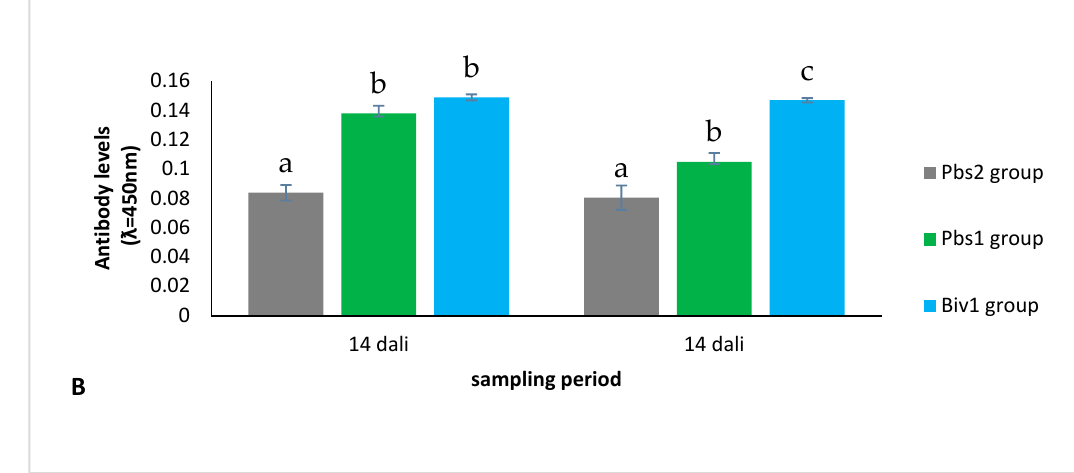
Figure 2. Antibody levels from the 14 and 21 days larvae homogenates after larval immunization against S. agalactiae antigens coating ( A ) and A. hydrophila antigens coating ( B ). Different superscript letters in the same sampling period showed significantly different immunization effects (Duncan’s test: p < 0.05). dali: days after larvae immunization.